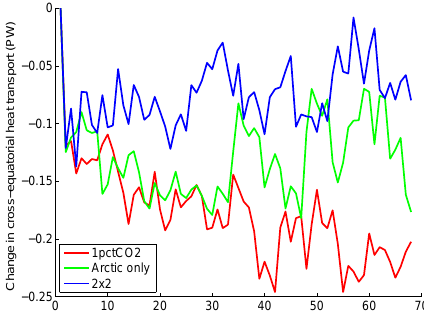
Figure A1. Change from the preindustrial control in cross- equatorial energy transport by the atmosphere (Eq. A1) for the 2 × 2 case in the design model. All values are annually averaged and ex- pressed in PW. For clarity, all plotted values were annually averaged and then smoothed (five-point centered moving average).